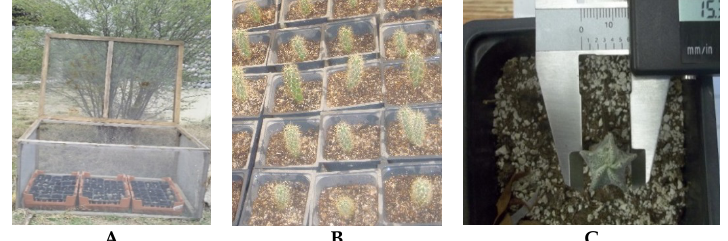
Figure 1. Field transfer: ( A ) Plants in three substrate types inside cages; ( B ) Plants establishment; ( C ) Measurements.